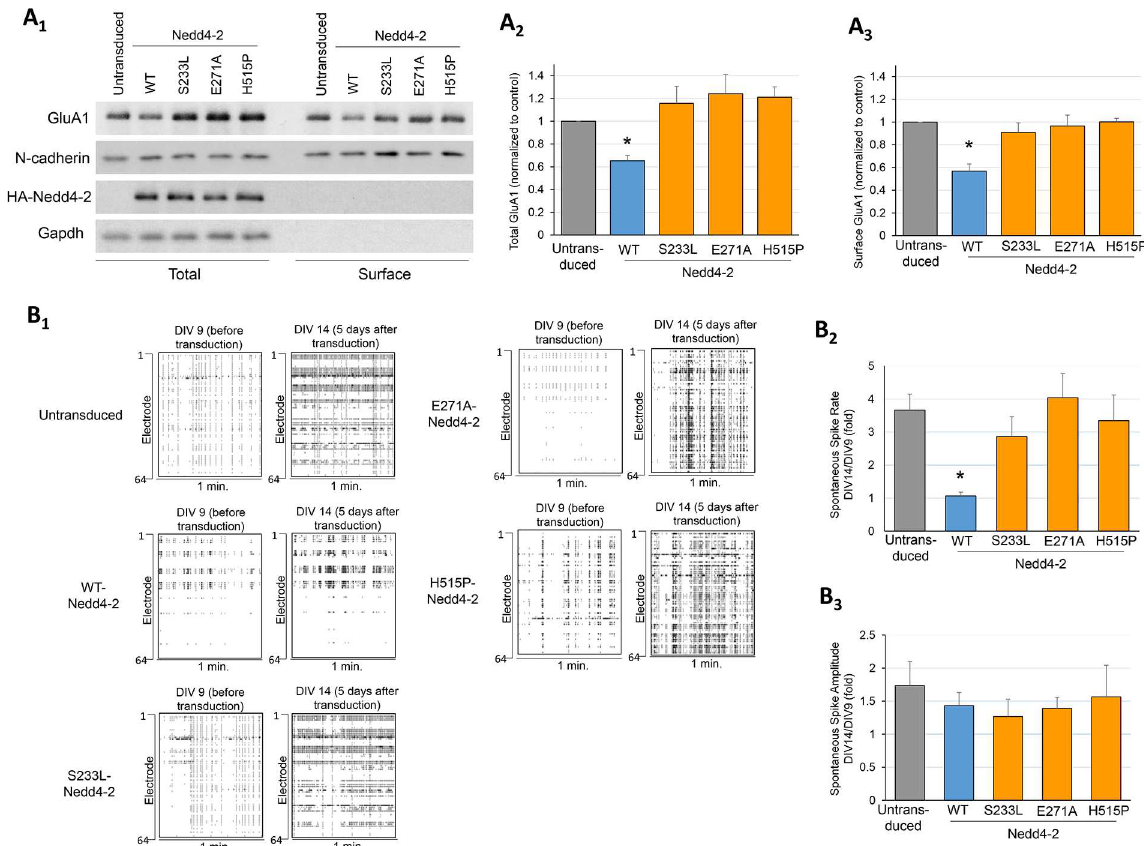
Fig 8. Three epilepsy-associated missense mutations of Nedd4-2 fail to mediate surfaceGluA1 level and spontaneous neuronal activity. ( A 1 ) Western blots of GluA1, N-cadherin, HA-Nedd4-2, and Actin from Nedd4-2 andi cultures lentivirallytransduced with or without WT or mutant Nedd4-2s for 5 days starting at DIV 9. Proteins from total lysate or after surface biotinylationwere as indicated. Quantification of ( A 2 ) total and ( A 3 ) surface GluA1 are on the right (n = 4, one-wayANOVA with post-hoc Tukey test). ( B 1 ) Representative raster plots, ( B 2 ) quantification of spontaneous spike rate from 1-min recordingand ( B 3 ) quantification of average spontaneous spike amplitudeof Nedd4-2 andi cortical neuroncultures lentivirallytransduced with or without WT or mutant Nedd4-2s for 5 days starting at DIV 9 (n = 5–7, one-wayANOVA with post-hoc Tukey test). Data are representedas mean ± SEM with * p < 0.05, ns: